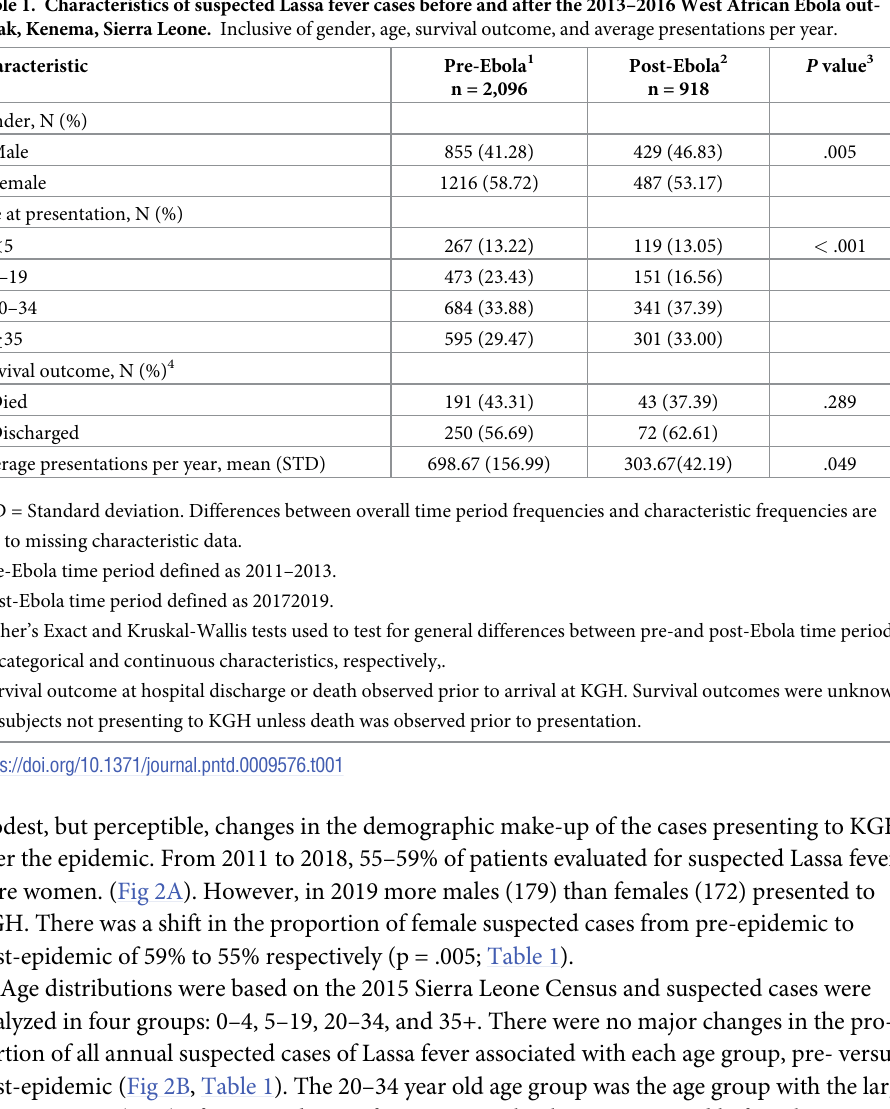
Table 1. Characteristics of suspected Lassa fever cases before and after the 2013–2016 West African Ebola out- break, Kenema, Sierra Leone. Inclusive of gender, age, survival outcome, and average presentations per year. Characteristic